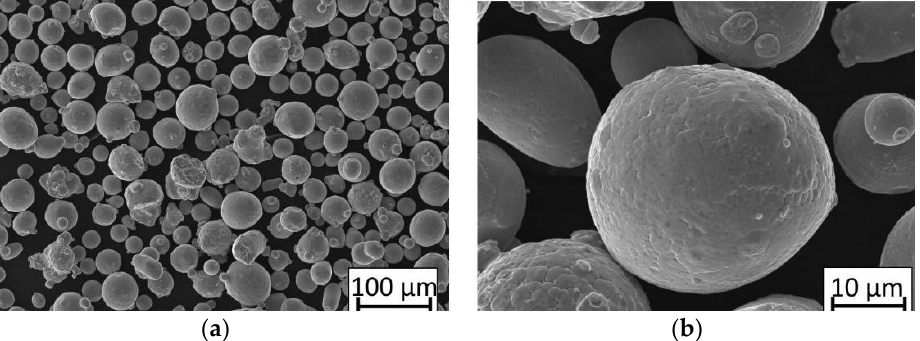
Figure 2. SEM images of 316L powder grains captured at scales of ( a ) 100 µm and ( b ) 10 µm.